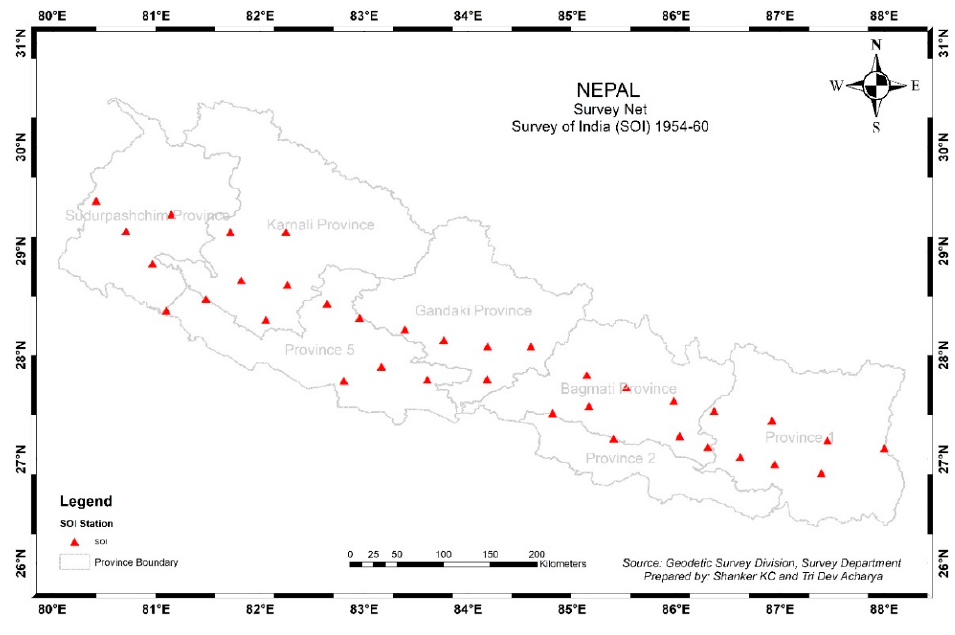
Figure 3. Survey network established by SOI in